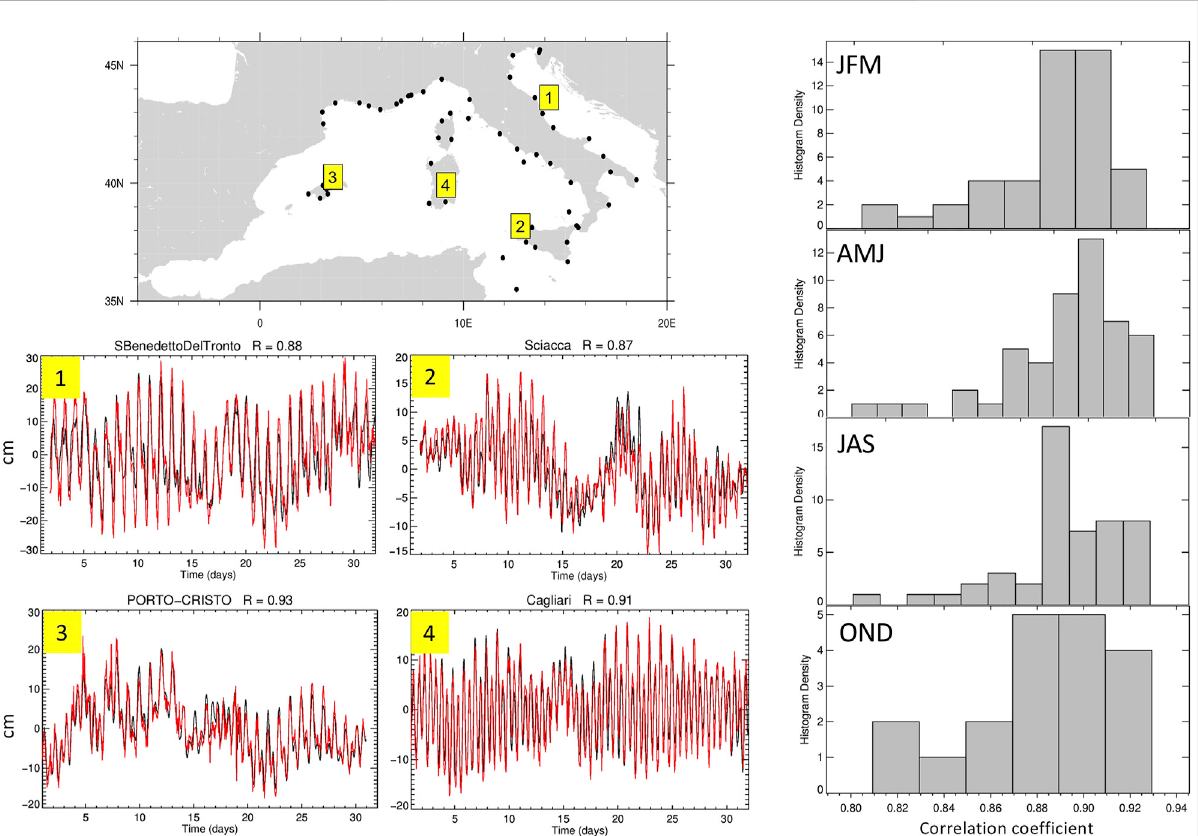
FIGURE 11 Left top panel: tidal stations for which elevation data are available for the year 2020 (not always with continuous coverage). The other panels show histograms of the correlation coef fi cients between model and observed data, for the four seasons (right) and January sea surface elevation time series at four stations (San Benedetto del Tronto, Sciacca, Porto-Cristo, and Cagliari, marked by the numbers 1,2,3, and 4 in the map. Observations are in black, and MITO data in red. Units are in